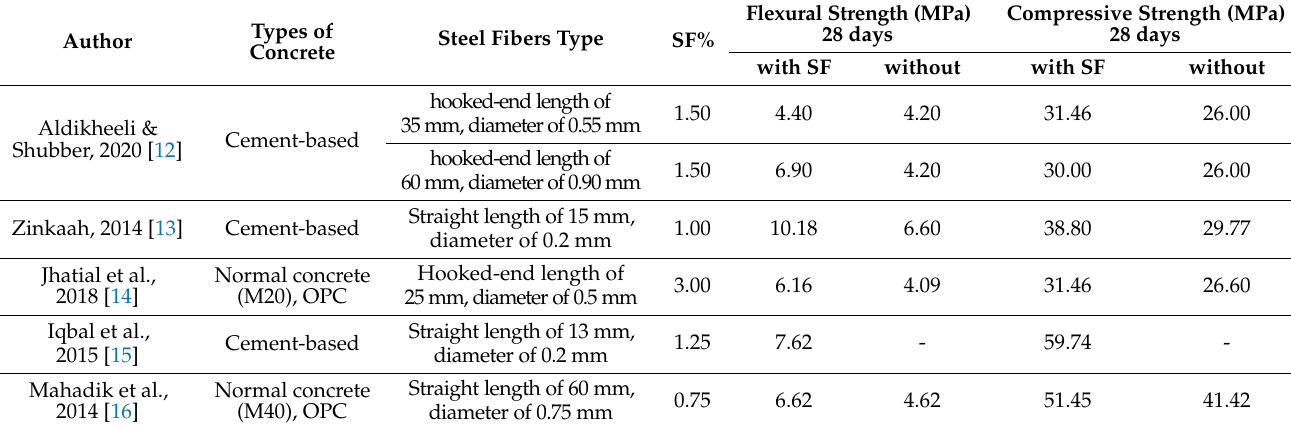
Table 1. Summary of relevant studies featuring steel fibers as the primary reinforcement in concrete composite based on the flexural and compressive